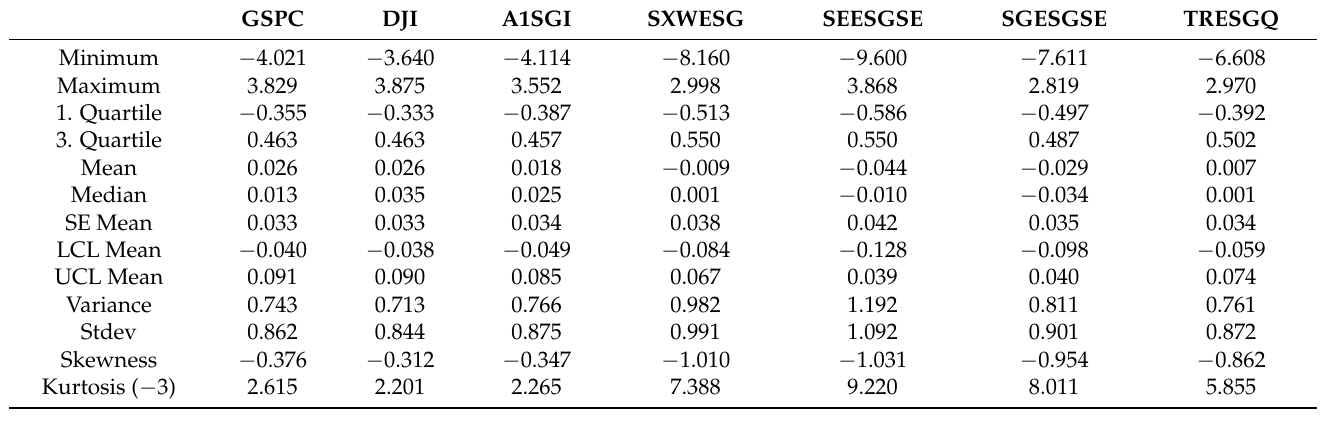
Table 7. Descriptive statistics, 3 June 2014–31 January 2017.